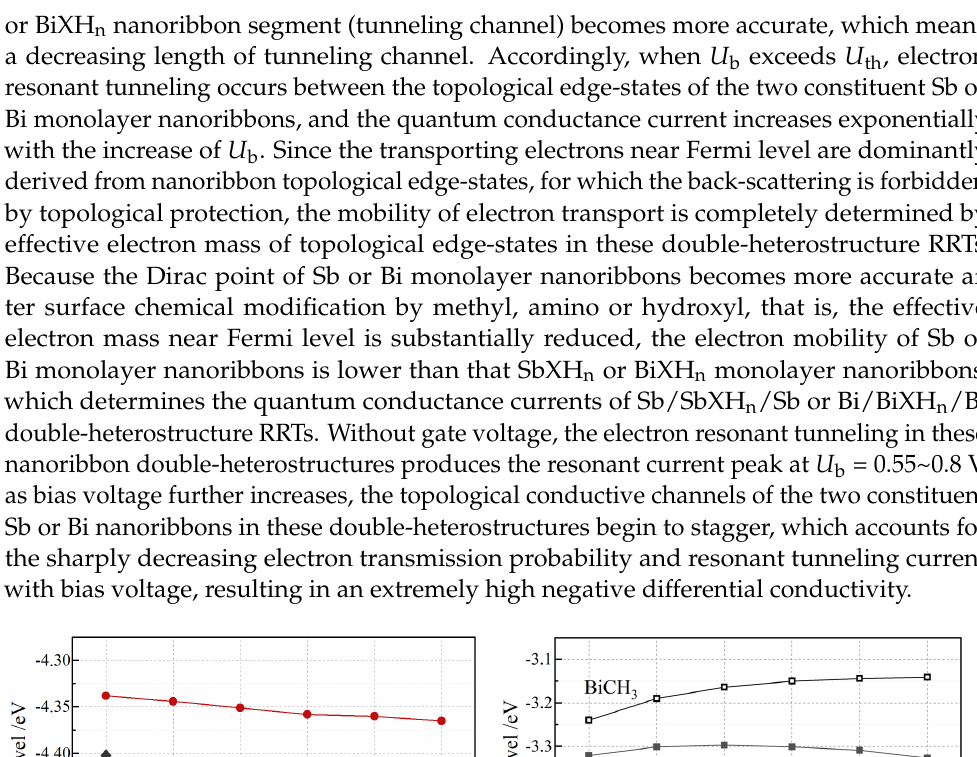
Figure 4. Fermi energy levels in dependence on nanoribbon width ( N w = 2~7) of Sb or Bi ( left panel ) and SbXH n or BiXH n ( right panel ) monolayer zigzag nanoribbons in reference to vacuum free electron energy level.